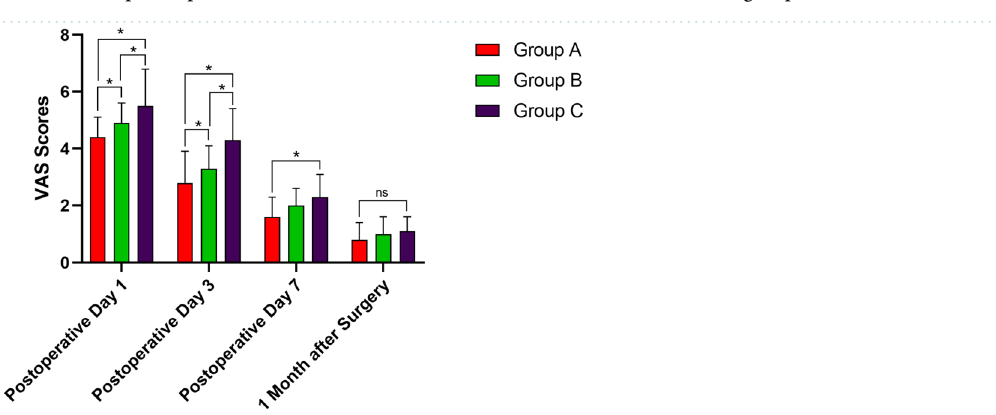
Figure 1. Differences of postoperative thigh pain VAS (visual analog scale) scores among groups. *represents the difference between these two groups was statistically significant ( P < 0.05); ns, represents no significant inter- group difference was